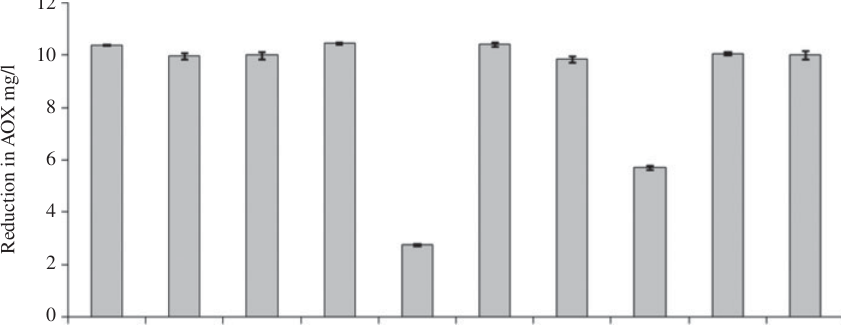
Fig. 1. Reduction in AOX level of Pulp and paper samples treated with different individual bacterial strains